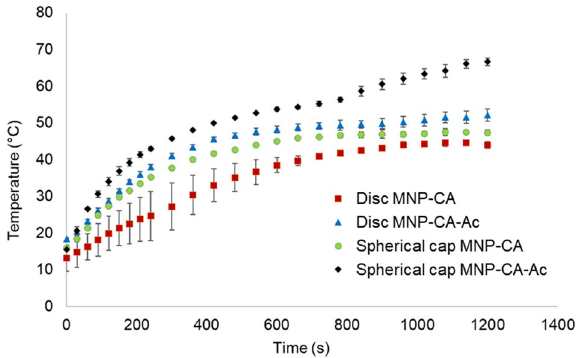
Figure 8. Heat transfer behavior of disc and spherical cap PVA-MNP cryogels, with and without acetaminophen coating against